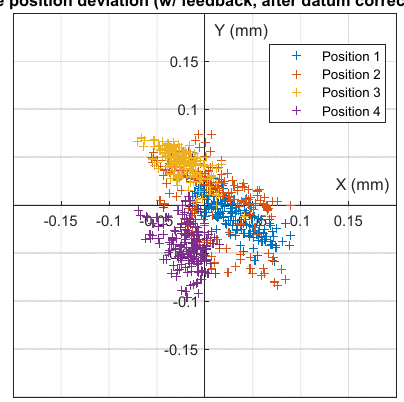
Figure 24. Best-fit hole center absolute position errors for after datum shift is removed.